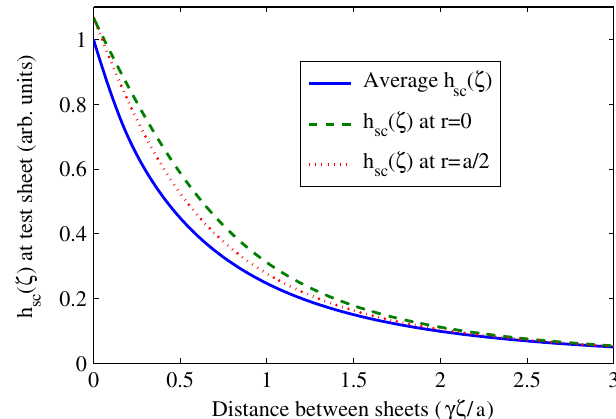
FIG. 3. Space charge from a source sheet produces a change in energy ( h sc ) in a test sheet located at a distance (cid:4) . We calculate the energy modulation to the test sheet by averaging over the entire sheet (solid blue curve). Though E z (and thus h sc ) is not constant everywhere in the test sheet, we note that there is relatively little variation near the center of the sheet, as can be seen from h sc evaluated at radius r ¼ 0 (dashed green line) and r ¼ a= 2 (dotted red line).